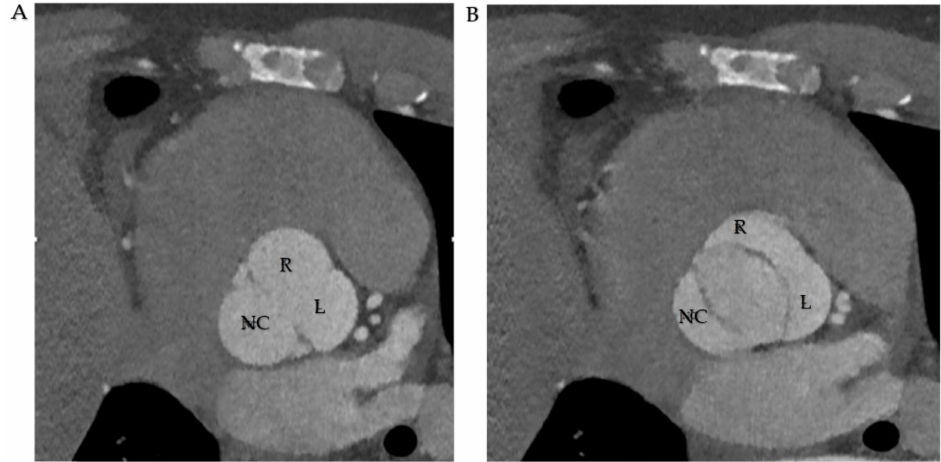
Figure 8. ( A , B ). CT scan in R-L cusp fusion. ( A ) Three sinuses are represented. ( B ). Opening mechanism in fusion pattern. Abbreviations; R, right coronary cusp; L, left coronary cusp; NC, non-coronary